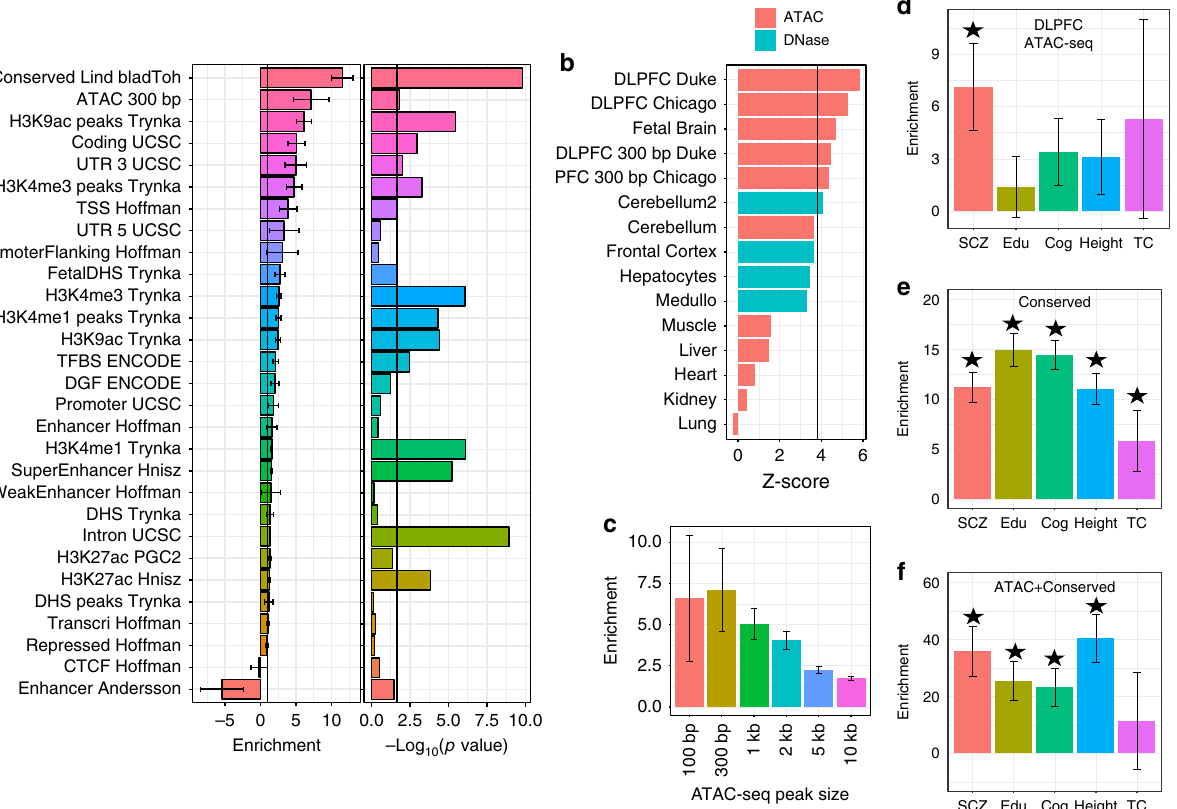
Fig. 2 Schizophrenia heritability is enriched for brain-speci fi c accessible chromatin. a Schizophrenia heritability enrichment (standard error) and signi fi cance level ( – log 10( P )) of different functional genomic annotations estimated using partitioned LD score regression. Enrichment of ATAC-seq regions in DLPFC is second only to genomic regions conserved across 29 Eutherian mammals. The black bar represents the 5% false discovery rate threshold. b Enrichment across a subset of 142 DNase-seq and ATAC-seq datasets (see Supplementary Fig. 9 for complete comparison). The black bar represents the Bonferroni signi fi cance threshold ( = 0.01/142). Top enrichments are in DLPFC ATAC-seq peaks generated from Duke and U Chicago groups, followed by other mostly brain-speci fi c tissues and cell lines. ATAC-seq tissue samples (cerebellum, liver, muscle, heart, kidney, and lung) represent an independent study to control for batch and method effects. c Schizophrenia heritability enrichment and standard error for peaks of different width. d Heritability enrichment of ATAC-seq peaks from brain display signi fi cant enrichment (* P < 0.05) for GWA variants associated with schizophrenia, but not for educational attainment (Edu), cognitive ability (Cog), height, and total cholesterol (TC). e Heritability enrichment of evolutionarily conserved regions are signi fi cantly enriched for schizophrenia, educational attainment, cognitive ability and height, and TC. f Heritability is ~4× more enriched for regions that overlap between ATAC-seq and conservation than for regions that are either conserved or in ATAC-seq